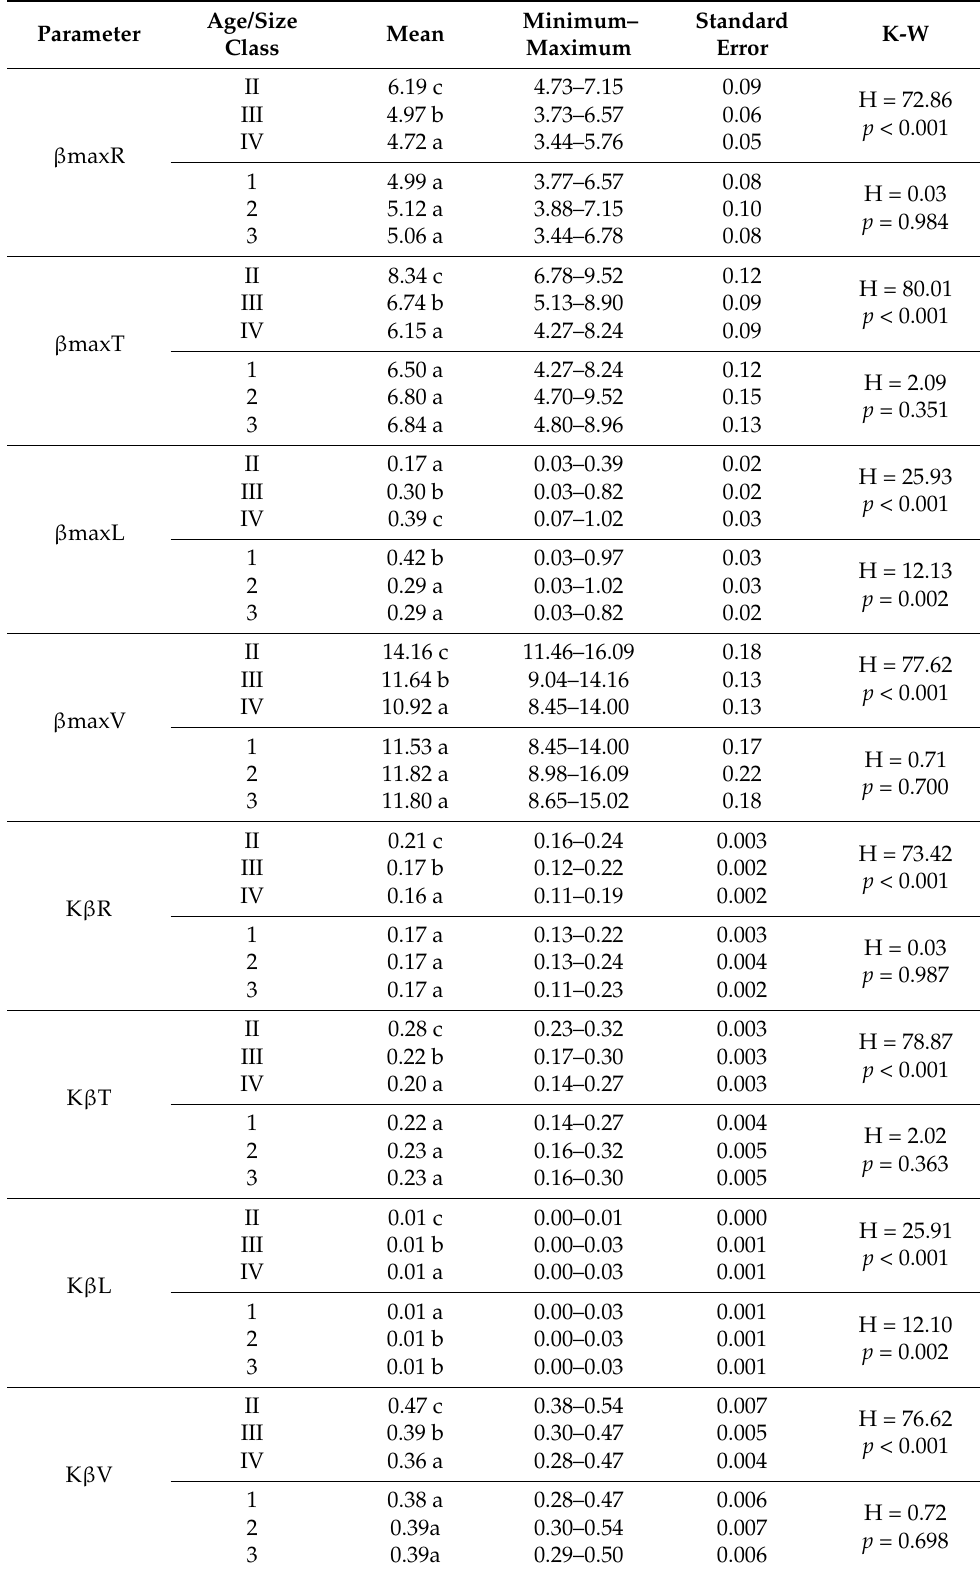
Table 3. Basic characteristics of radial ( β maxR, %), tangential ( β maxT, %), longitudinal ( β maxL, %) and volumetric ( β maxV, %) shrinkage and their respective coefficients (K β R, K β T, K β L and K β V, %) as well as anisotropy (A β , %) of black locust wood in relation to tree’s age class (II–IV) and size class (1–3) as well as parameters of Kruskal–Wallis comparison